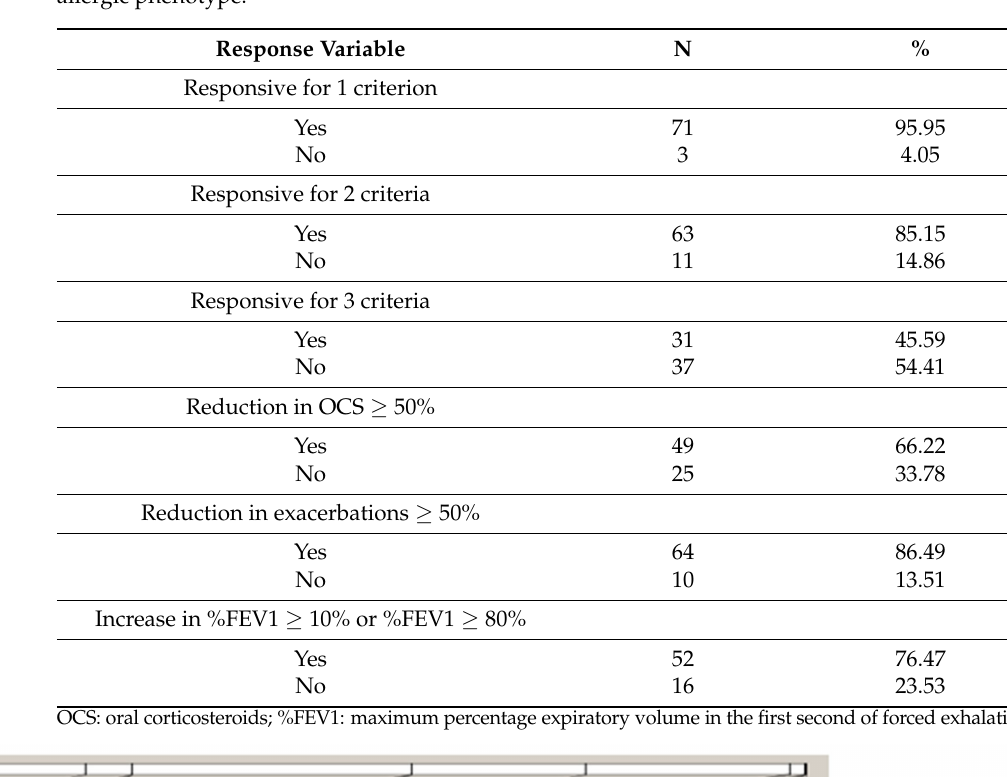
Table 2. Clinical effectiveness of omalizumab in patients with severe uncontrolled asthma and allergic phenotype.